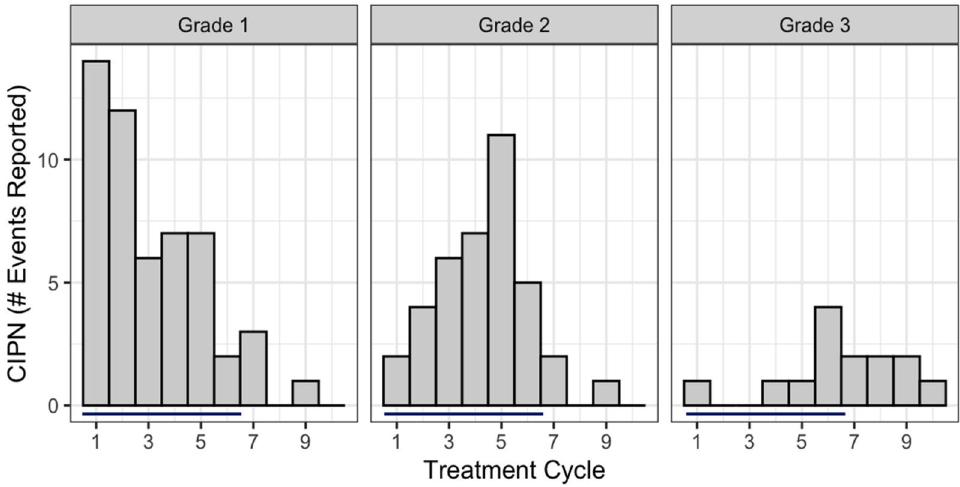
Figure 2. Temporal distribution of CIPN by grade. Bars indicate cycles scheduled for administration of paclitaxel and carboplatin.